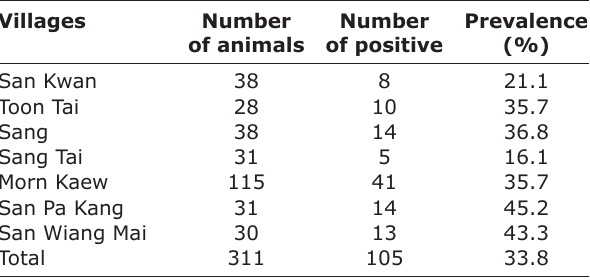
Table-1: Prevalence of fluke infection among beef cattle reared nearby Phayao Lake, Phayao, North Thailand (seven villages).